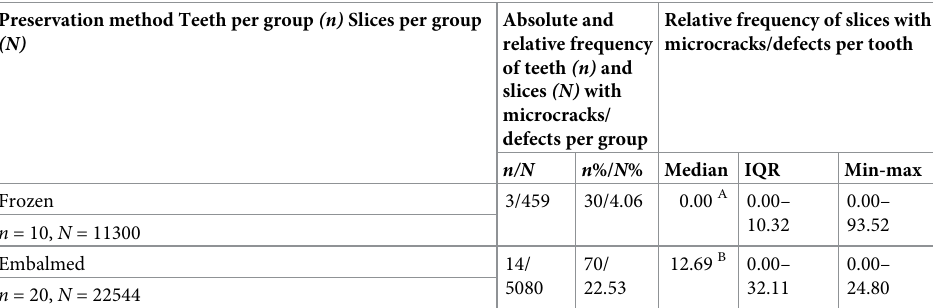
Table 1. Absolute and relative frequency of preoperative microcracks/defects for frozen and embalmed specimens at the group-level and percentage of slices with microcracks/defects at the